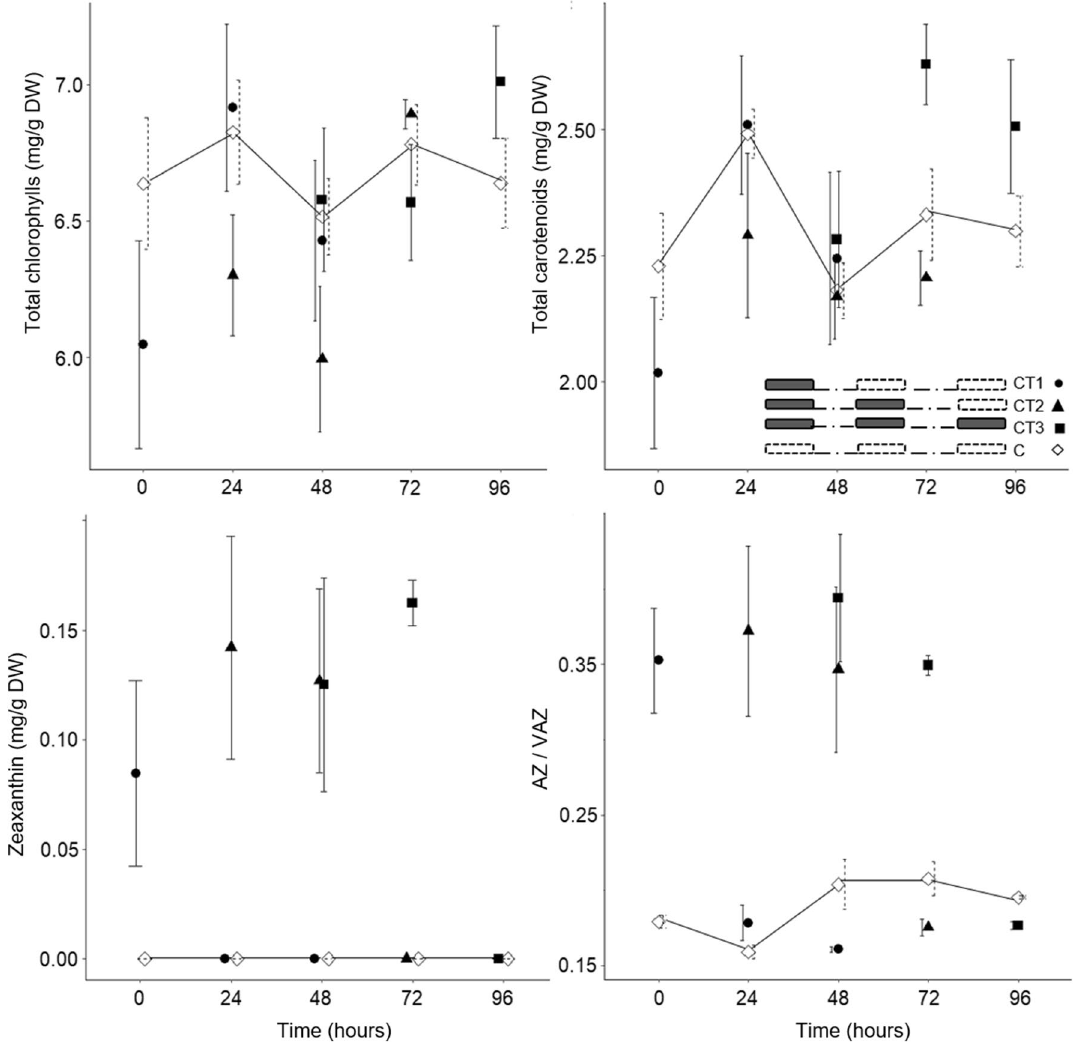
Figure 3. The total chlorophylls, total carotenoids, zeaxanthin content and AZ/VAZ (deepoxidation state of xanthophyll cycle pool) in leaves of ‘Grace Star’ sampled at time 0, time 24, time 48, time 72 and time 96 in Experiment II. Vertical bars represent ± SE of the mean (n = 3; n = 3, 6 or 9 for controls). For other bar details, see Fig.